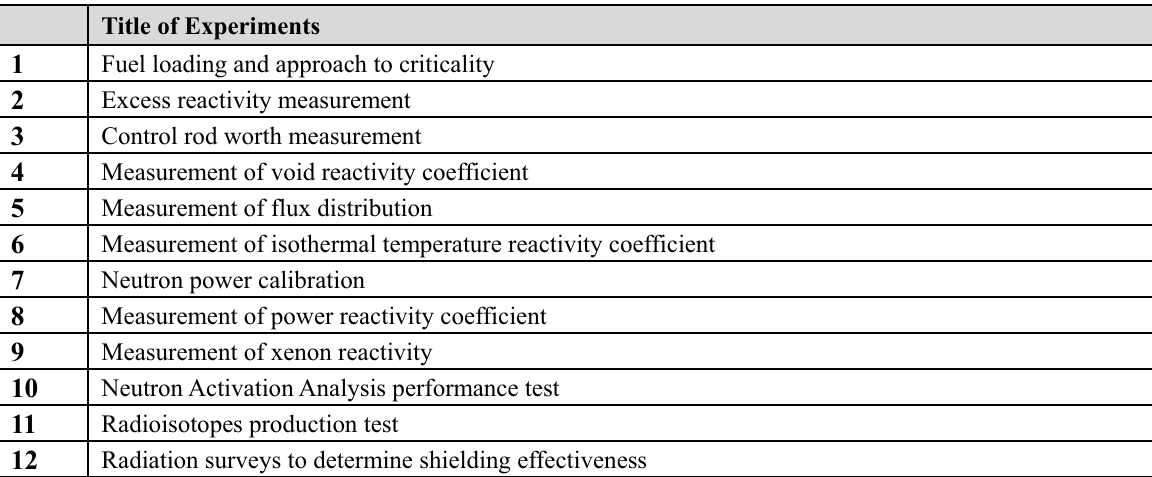
Table IV. Reactor Physics Experimental Proposed for